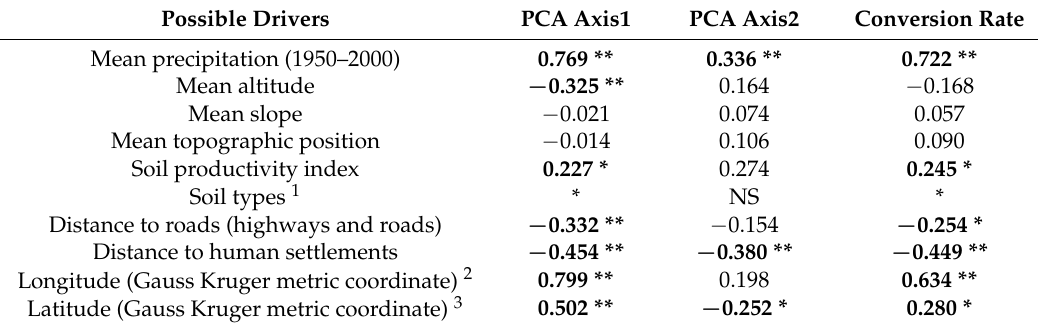
Table 3. Pearson correlations between possible drivers of change and the first two axes of the PCA ordination and the conversion rate into agriculture.